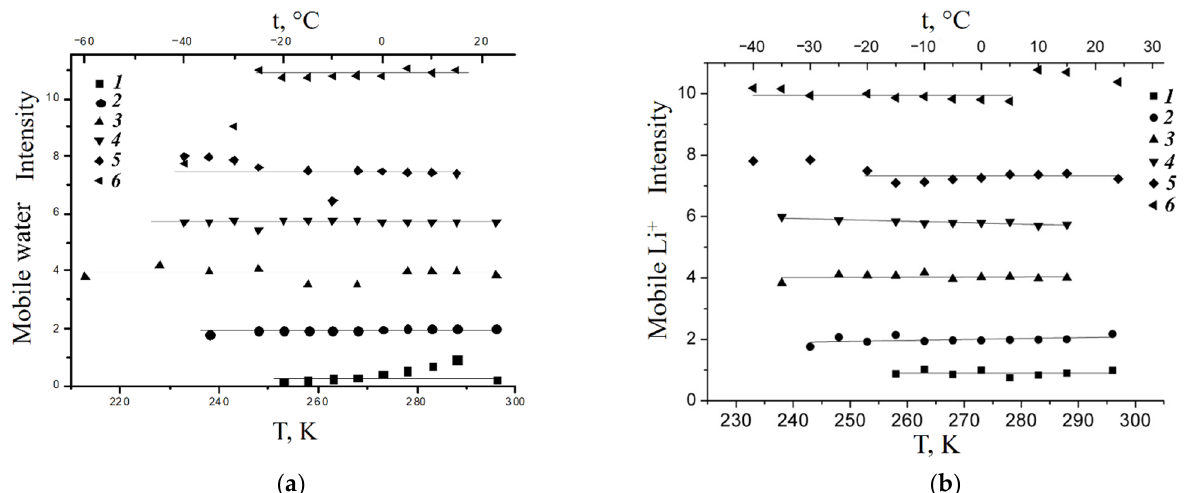
Figure 17. Dependences of the number of mobile water molecules per sulfonated group λ ( a ) and mobile Li + cations ( b ) on temperature in the lithium ionic form of the Nafion 117 membrane; ( a ) amount of mobile water molecules per sulfonate group: (1) λ = 0.9, (2) λ = 2.0, (3) λ = 4.0, (4) λ = 5.7, (5) λ = 7.4, (6) λ = 10.7. ( b ) Relative intensity of 7 Li + mobile signals: (1) λ = 0.9, (2) λ = 2.0, (3) λ = 4.0, (4) λ = 5.7, (5) λ = 7.4, (6) λ = 10.7. Reprinted with permission from Ref. [24]. Copyright 2021 MDPI.